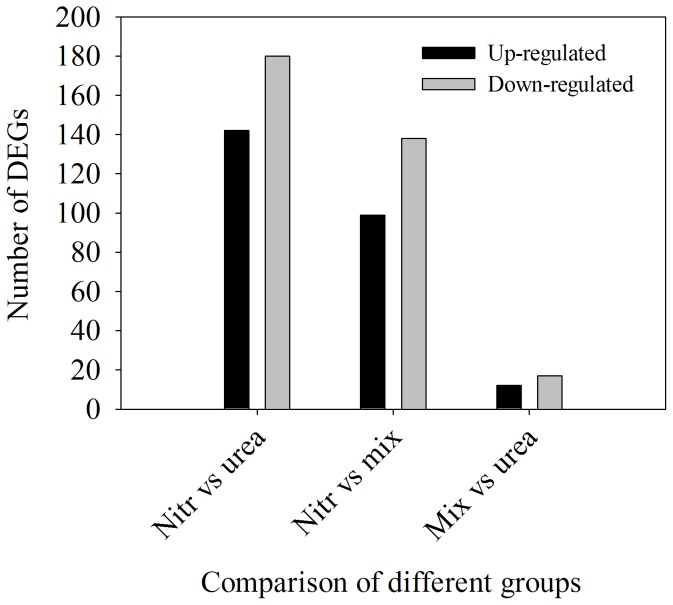
The number of differentially expressed genes among cells that were grown on the three N sources.Nitr, urea and mix represent cells grown on nitrate, urea and mixture N, respectively.